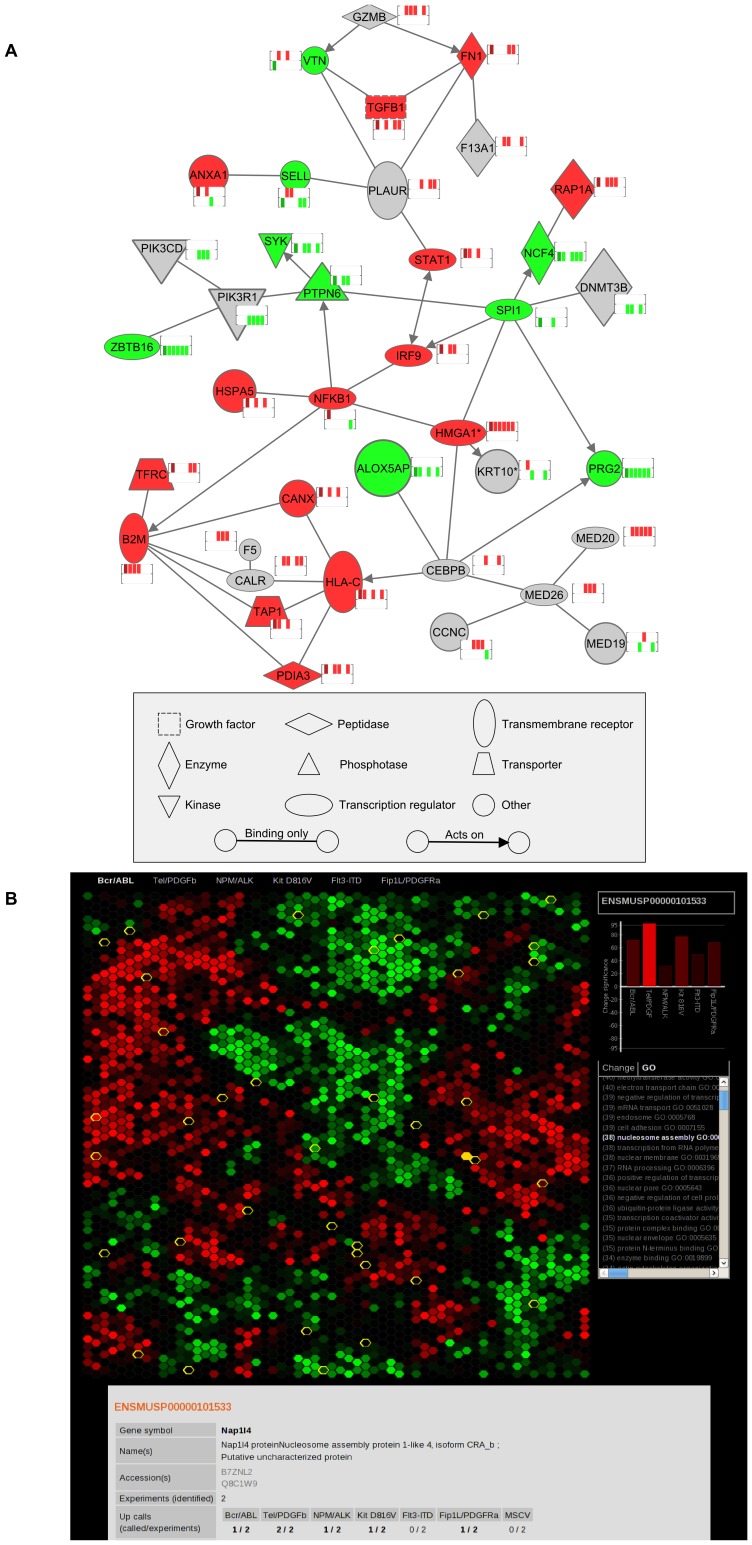
Schematic analyses of proteomic data.
Figure 7a: Ingenuity pathway analysis software was used to examine the HMGA1 interaction network within the differentially regulated proteins/phospho-peptides regulated by oncogenic PTKs found in the study. Immediate interactors that are differentially regulated in at least two oncogenes are shown while further interaction relationships are shown where differential regulation is indicated in three or more oncogenes. The mini-heatmaps show the regulation seen in the six oncogenes. Red indicates up-regulation and green down-regulation. From left to right the six columns show BCR/ABL, TEL/PDGFRβ, NPM/ALK, Kit D816V, Flt3-ITD and Fip1L/PDGFRa. Figure 7b; A screen snap of the interactive web-based viewer used to display the data. The web site can be found at http://www.scalpl.org/scope3/.